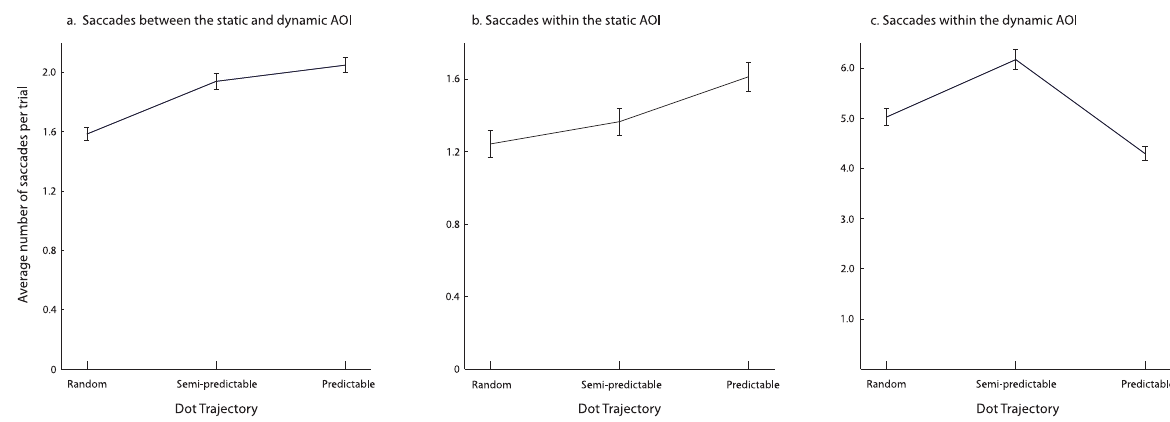
Fig 6. The number of saccades a. between the AOIs, b. within the static AOI and c. within the dynamic AOI, depending on the dot trajectorypredictability. Note that for the clarity of presentation of results each diagramhas a different scale on the y-axis.